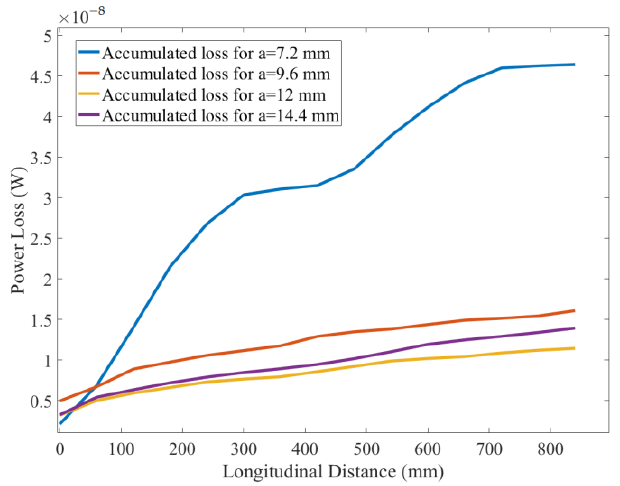
Figure 10. Power loss in each section for different edge length a .